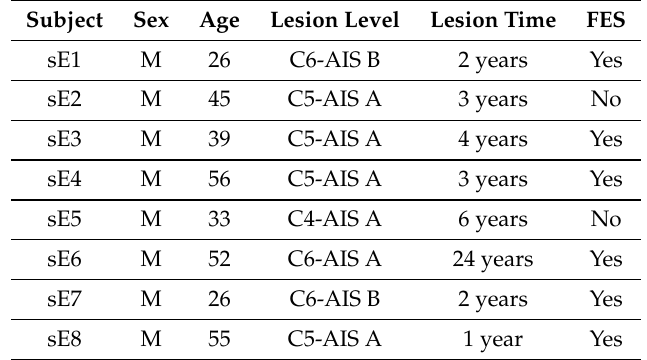
Table 1. Subject characteristics for the electromyography (EMG) group.